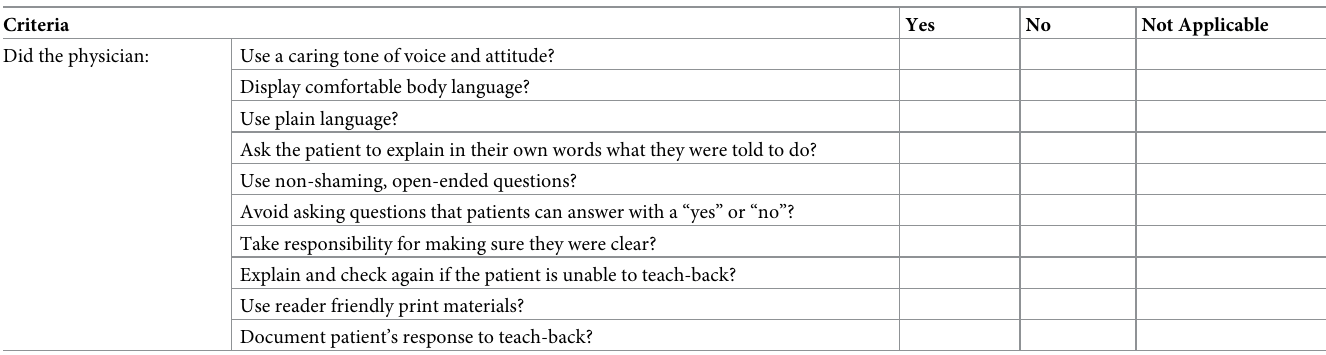
Table 1. Adapted observation tool [37].